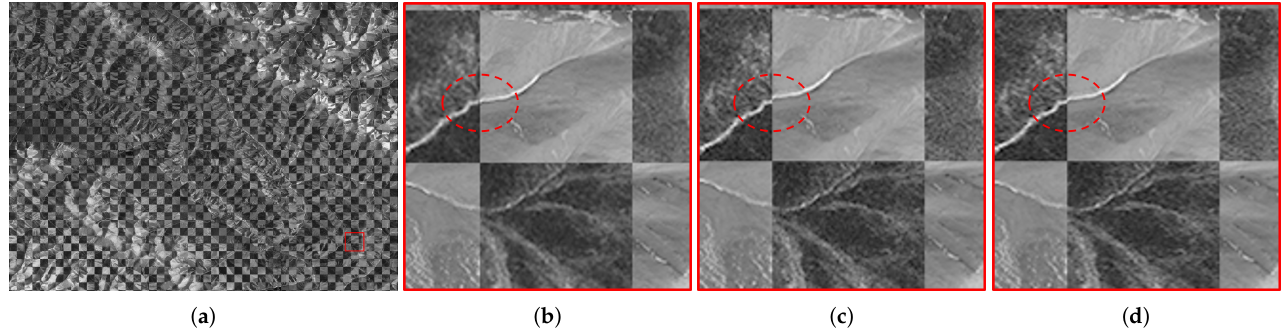
Figure 24. Checkboard mosaic image and enlarged sub-images of Pair G: ( a ) checkboard mosaic image of HOPES; ( b – d ) enlarged sub-images of HOPES, CFOG, HOPC.